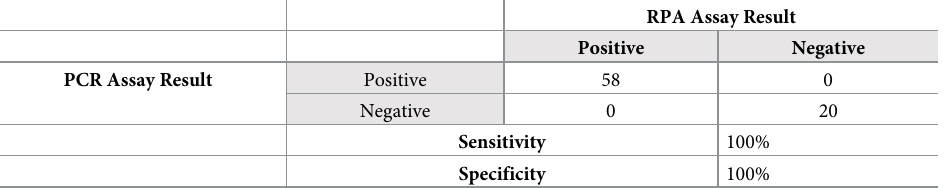
Table 3. Clinical sensitivity and specificity. Sensitivity and specificity of two-step RT-RPA were evaluated using clin- ical human serum samples that were HCV-positive or HCV-negative. Samples were confirmed positive or negative with a gold-standard PCR